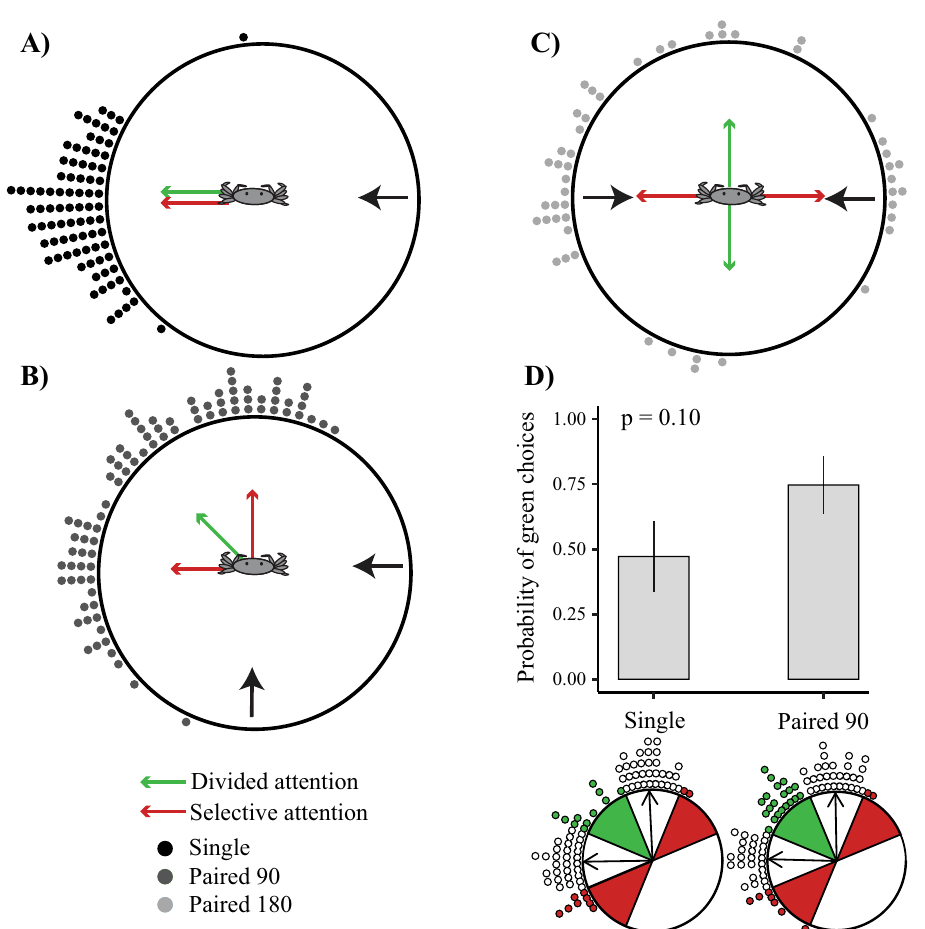
Figure 3. Escape directions in response to single or paired predators. Crabs were exposed to either ( A ) a single looming stimulus (Single, black circles), ( B ) paired looming stimuli that differed in their approach angle by 90° (medium-grey circles, Paired 90), or ( C ) paired looming stimuli that differed in their approach angle by 180° (light-grey circles, Paired 180). Black arrows show the predator approach direction, and the green and red arrows show the predicted running directions under a divided attention or selective attention mechanism respectively. ( D ) The divided attention hypothesis predicts a higher number of crabs to run into the green sector than to run into the combined red sectors. In contrast, the selective attention hypothesis predicts an equal distribution. To test this, we compared the running directions of crabs that faced a single predator with those that faced two predators. The probability of crabs running into the green or combined red sectors is not significantly different between the two treatments. The insets below the x-axis show circular diagrams of the binning protocol that captures the data points that align with divided attention mechanism (green circles) and those that do not (red circles). The white circles show the data that belongs to the central 45° of each distribution and therefore were not analysed. The black arrows in these insets show the mean running directions of the white points only. The p value shows the result of a generalized mixed effects model (GLMM, d.f. = 1, χ 2 = 2.74, p =